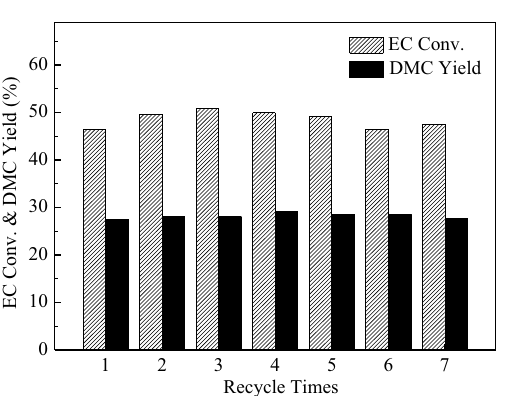
Figure 12. The effect of recycle times on EC conversion and DMC yield. Reaction conditions: EC/MeOH = 1/6, catalyst amount = 3 wt%, reaction temperature = 68 °C, reaction time = 0.5